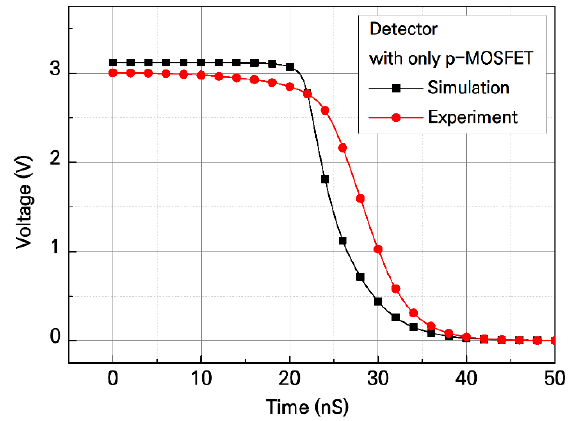
Figure 13. Response time measurement result of the proposed pulsed-radiation detection circuit.